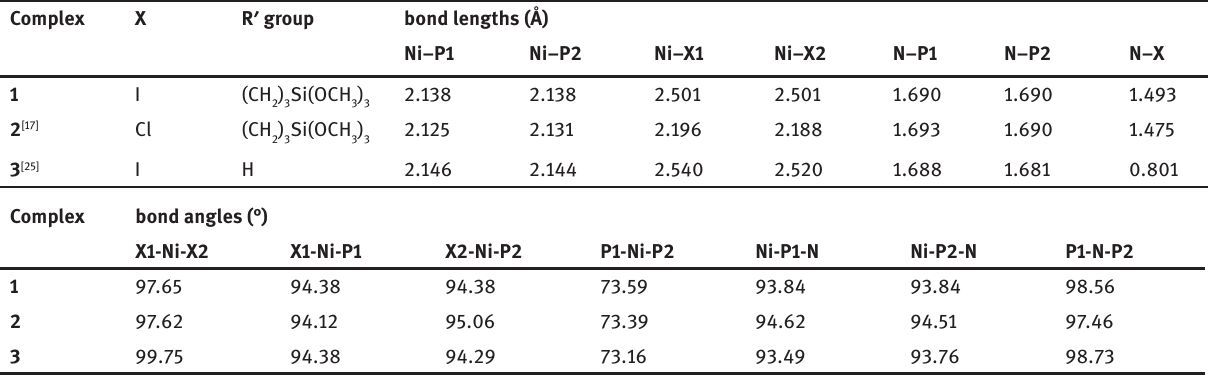
Table 2 : Selected bond lengths and angles of complexes 1 , 2 and 3 .